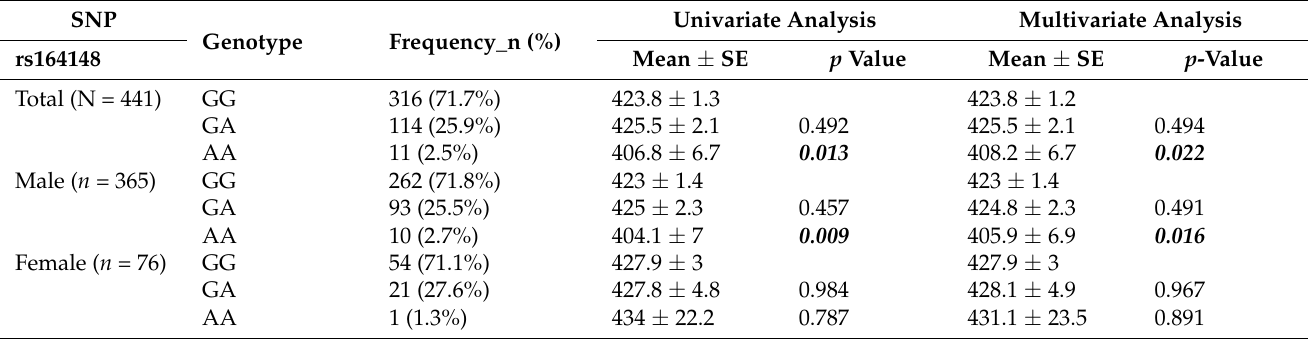
Table 3. Associations between NOS1AP rs164148 genotypes and QTc intervals by univariate analysis and multivariate analysis in total, in male, and in female